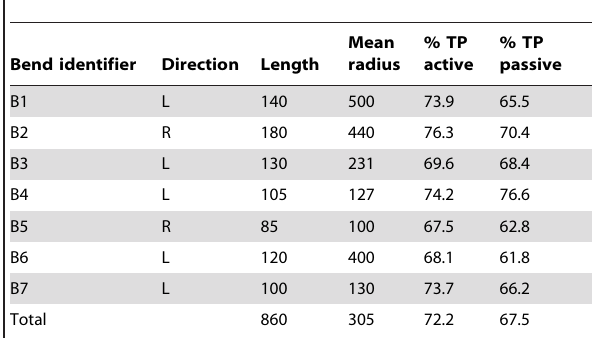
Table 1. Characteristics and results for individual bends.